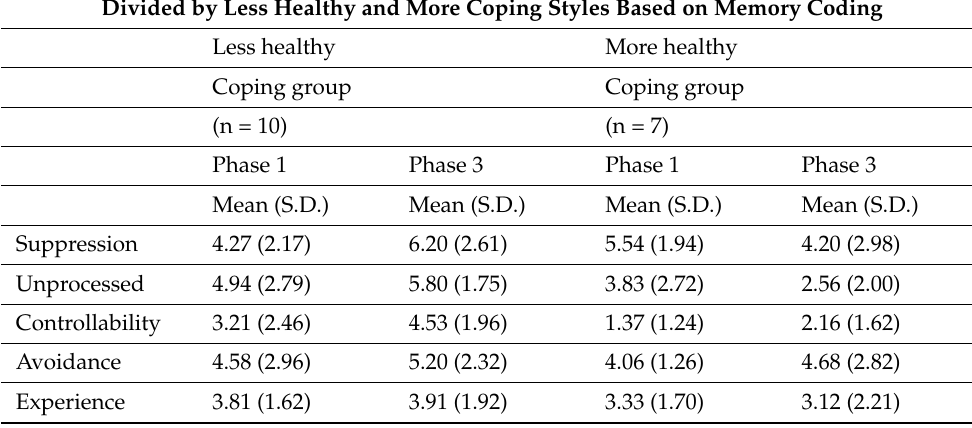
Table 3. Means and standard deviations for the emotional processing subscales. Divided by Less Healthy and More Coping Styles Based on Memory Coding Less healthy More healthy Coping group Coping